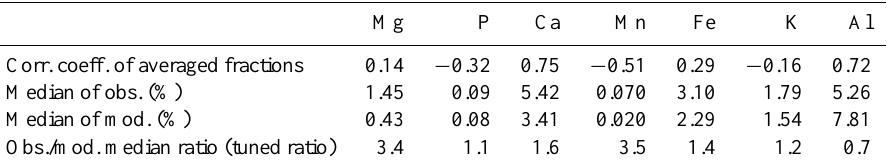
Table 3. Comparison of modeled and observed fractions of chemical elements in TSP, and tuning ratio based on 13 site measurements. (For this table comparing the elemental ratios at the measurement sites, the percentage value at each time measured is averaged across time and space for this